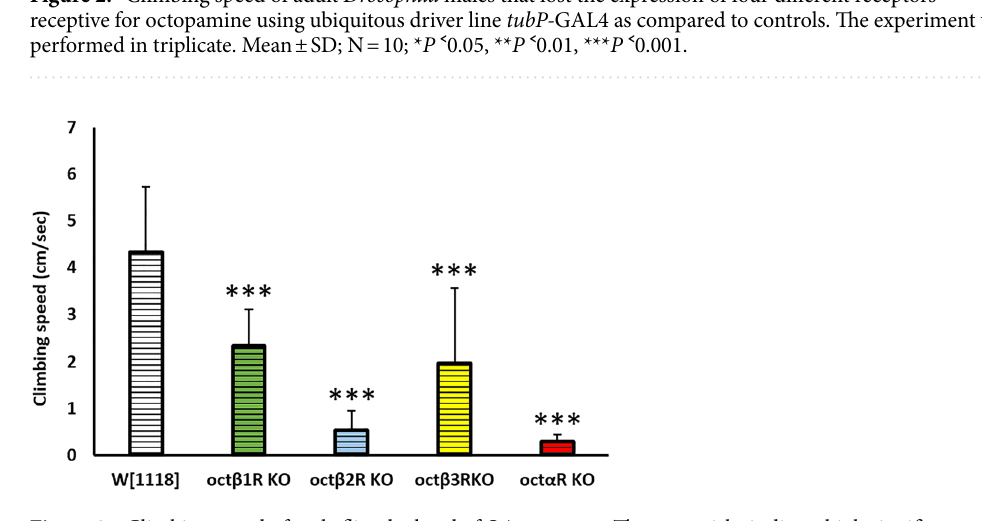
Figure 3. Climbing speed of male flies depleted of OA receptors. Three asterisks indicate high significance (Student t-test: P ˂